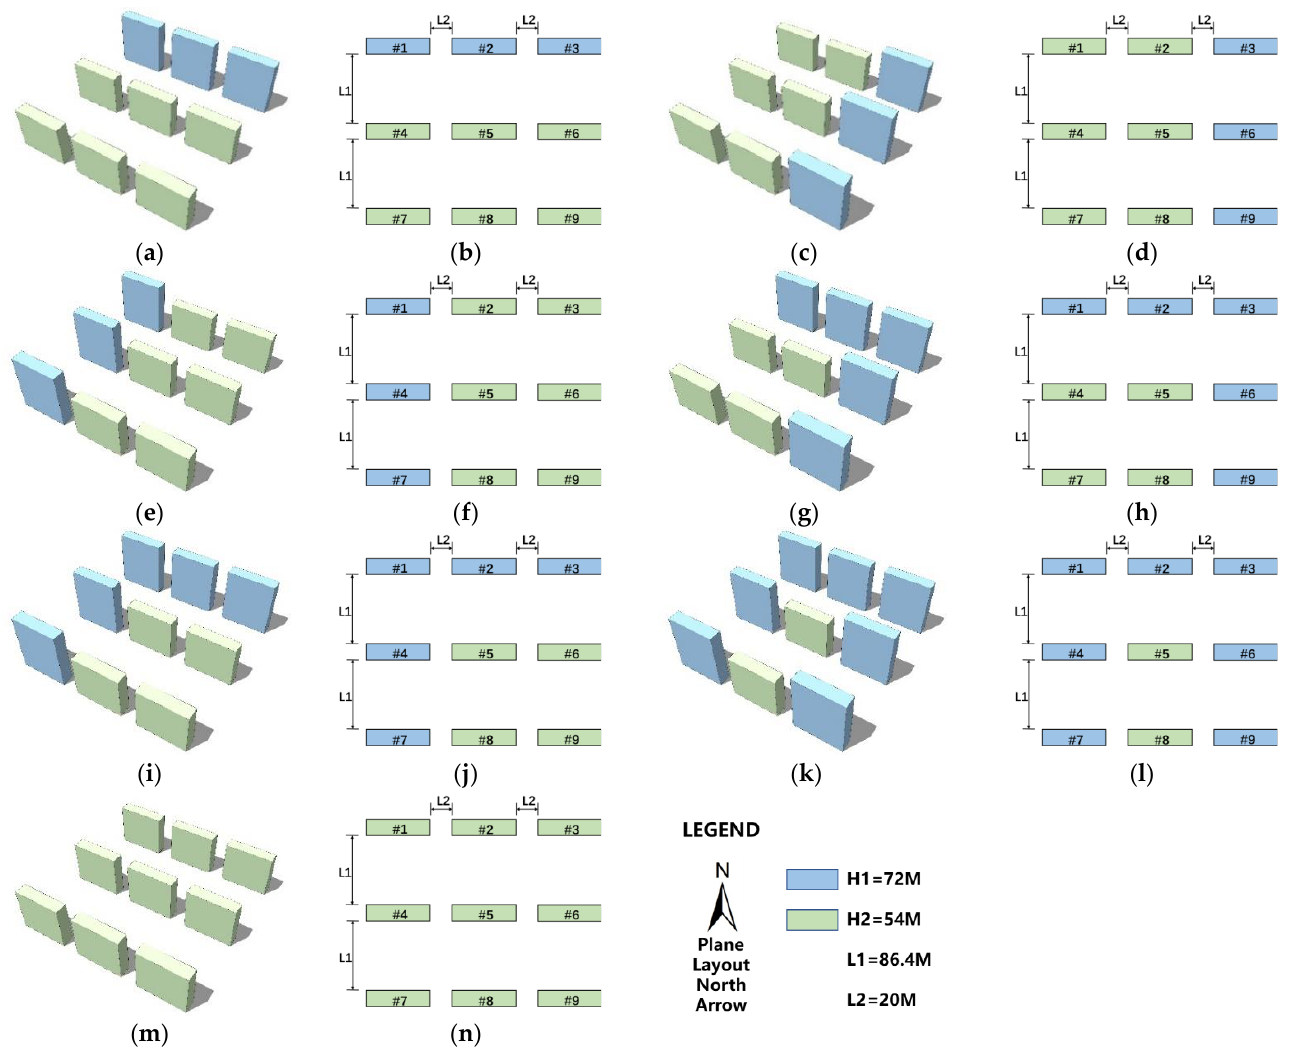
Figure 3. Schematic diagram showing building height, spacing, numbering, and 3D model of seven building distribution patterns: ( a ) north side high (1-N) 3D model, ( b ) north side high (1-N) plan layout, ( c ) east side high (1-E) 3D model, ( d ) east side high (1-E) plan layout, ( e ) west side high (1-W) 3D model, ( f ) west side high (1-W) plan layout, ( g ) east and north side high (2-EN) 3D model, ( h ) east and north side high (2-EN) plan layout, ( i ) west and north side high (2-WN) 3D model, ( j ) west and north side high (2-WN) plan layout, ( k ) east – west and north side high (3-EWN) 3D model, ( l ) east west and north side high (3-EWN) plan layout, ( m ) uniform building height (UBH) 3D model, and ( n ) uniform building height (UBH) plan layout.